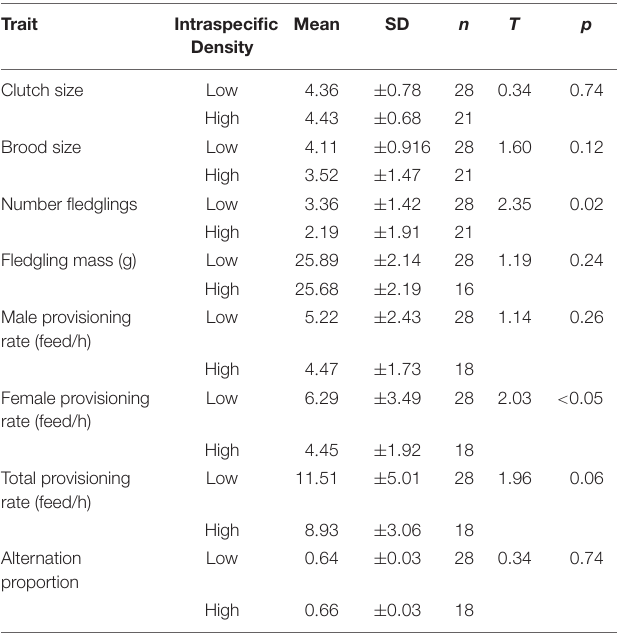
TABLE 1 | Comparison of reproductive parameters of the bluebird nests in relation to tree swallow density (i.e., low versus high density areas).